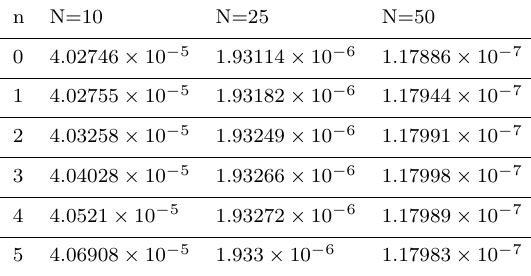
Table 1. Integrals of the squared residual errors for Example 1 with m=10 iterations and various N = 10 , 25 and 50.